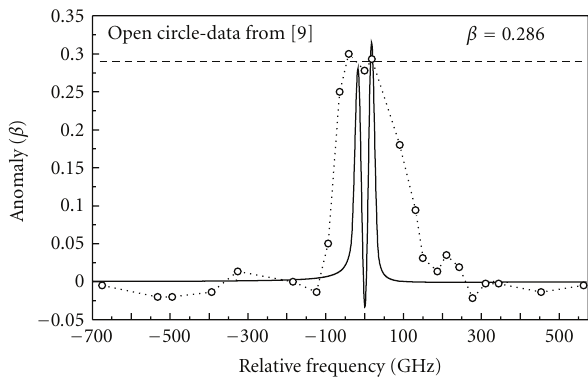
Figure 4: Anomaly ( β ) of tin isotopes for the 5p 2 ( 3 P 0 ) − 5p 6s ) (286.3317nm) transition for a laser linewidth of 15GHz and ( 3 P 0 1 a Doppler width of